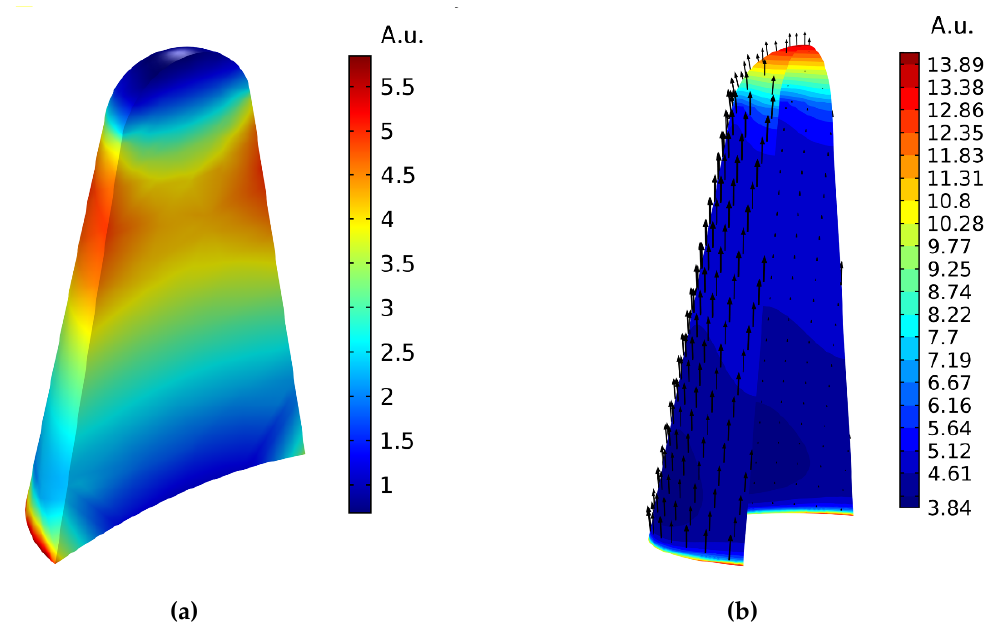
Figure 9. Regions of absorption localization: topogram of the intensity distribution of the radiation absorption density in the central section of the GNS tip shown in Figure 3b ( a ); a schematic repre- sentation of the distribution of the electric field vector on the inner surface of the tip (inside GNS) ( b ). GNS is irradiated with laser light linearly polarized along the tip axis at a plasmon resonance wavelength of 665 nm.